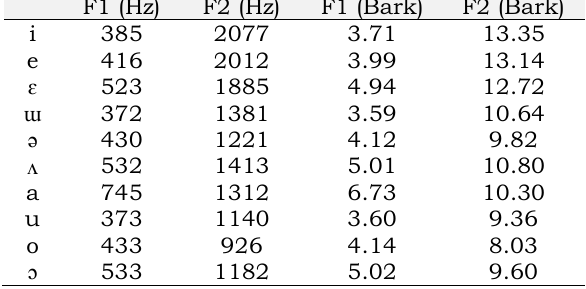
Table 2. Formant values of Acehnese monophthongs in Hertz (Hz) and Bark F1 (Hz) F2 (Hz) F1